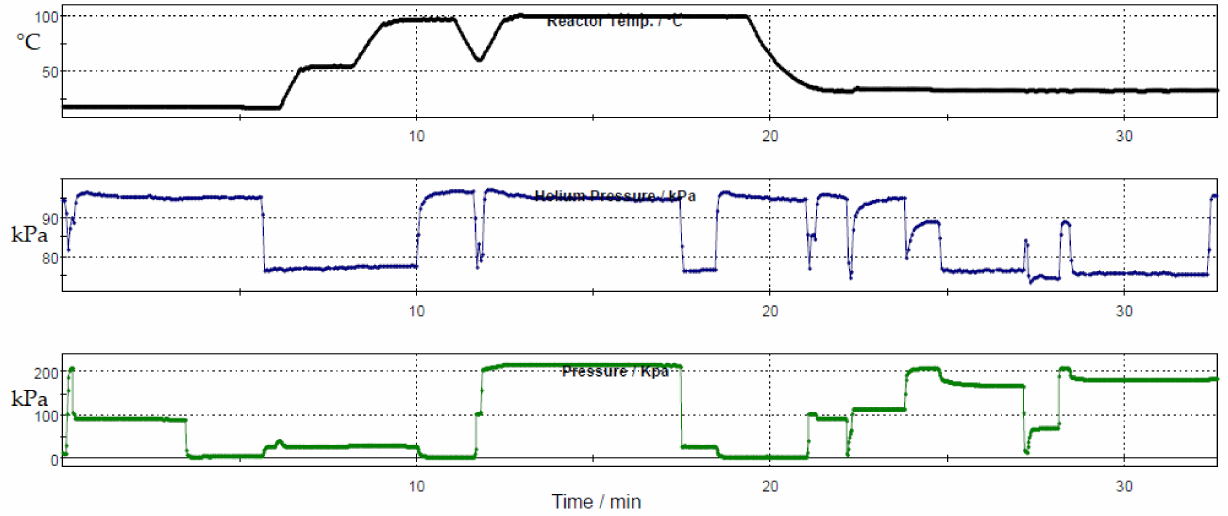
Figure 2. Trendings (temperature, helium pressure, reactor pressure/time) for [ 18 F]F-FETEM using GE Tracerlab FXFDG synthesis